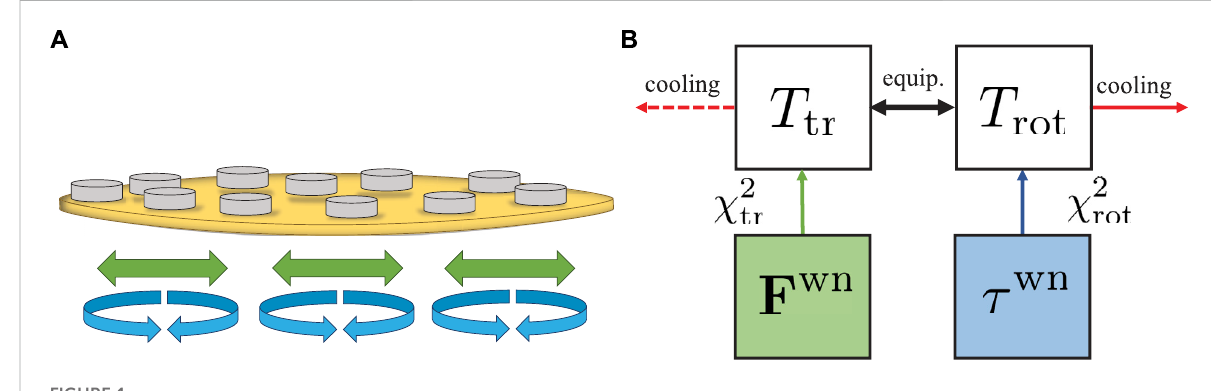
FIGURE 1 (A) Illustration of the system, where the green horizontal straight arrows and the blue curved ones represent the stochastic force F wn and the stochastic torque τ wn inEqs.2,respectively. (B) Mechanism ofinjection-dissipationofenergyintheintroducedmodel. Dissipativecollisionsproduce a cooling effect on the translational and rotational temperatures ( T tr and T rot ), together with a transfer between the translational and rotational energies (equipartition effect). Additionally, the external white-noise force and torque inject energy (heating